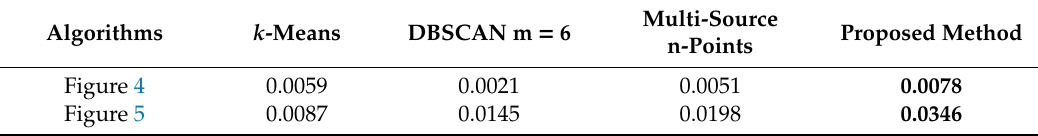
Figure 5. Outcomes of di ff erent clustering methods for data from 50 i.i.d. Table 2. Computing time of di ff erent clustering methods (s).